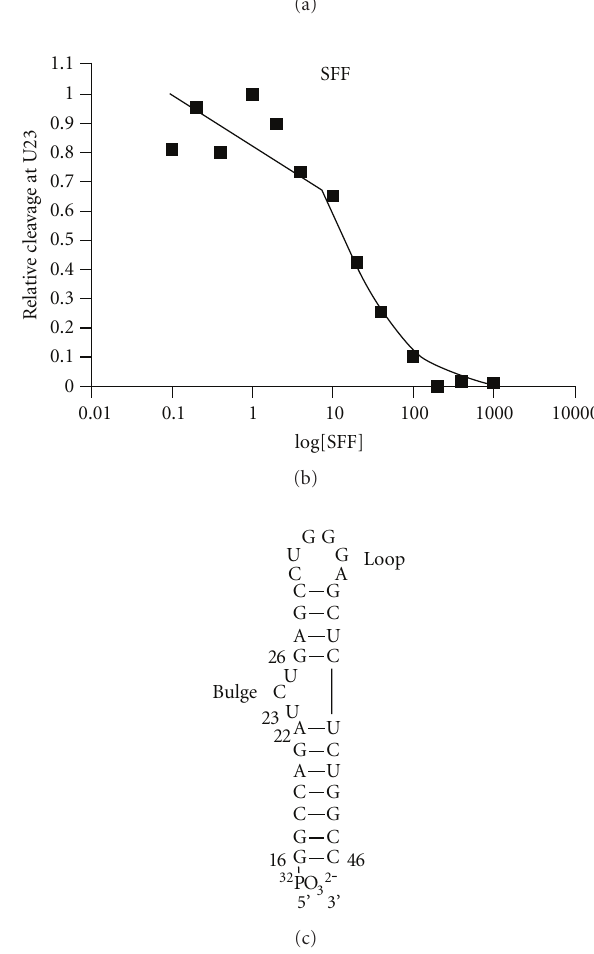
Figure 3: (a) Sequences of PAA “hits” from the initial screen and their corresponding dissociation constants for the bulge region of TAR. (b) Binding curve for SFF as determined by quantifying changes in cleavage at U23 as a function of SFF concentration (c) Structure of TAR RNA hairpin.